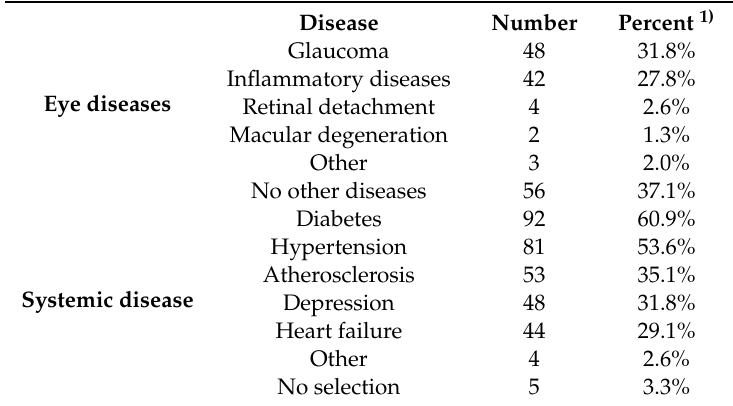
Table 2. Other eye diseases and systemic diseases in the studied group of patients.